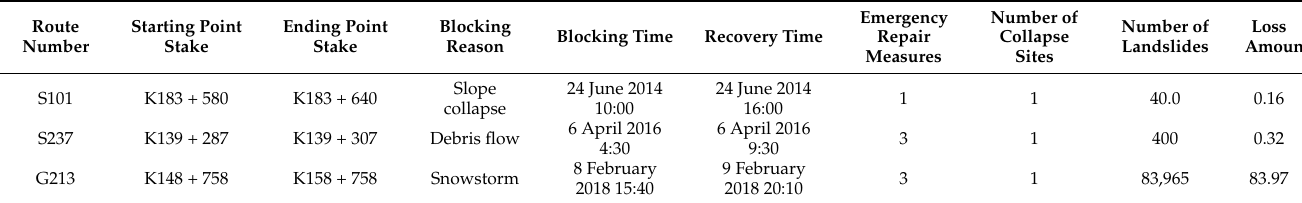
Table 1. Original data of partial blocking events.